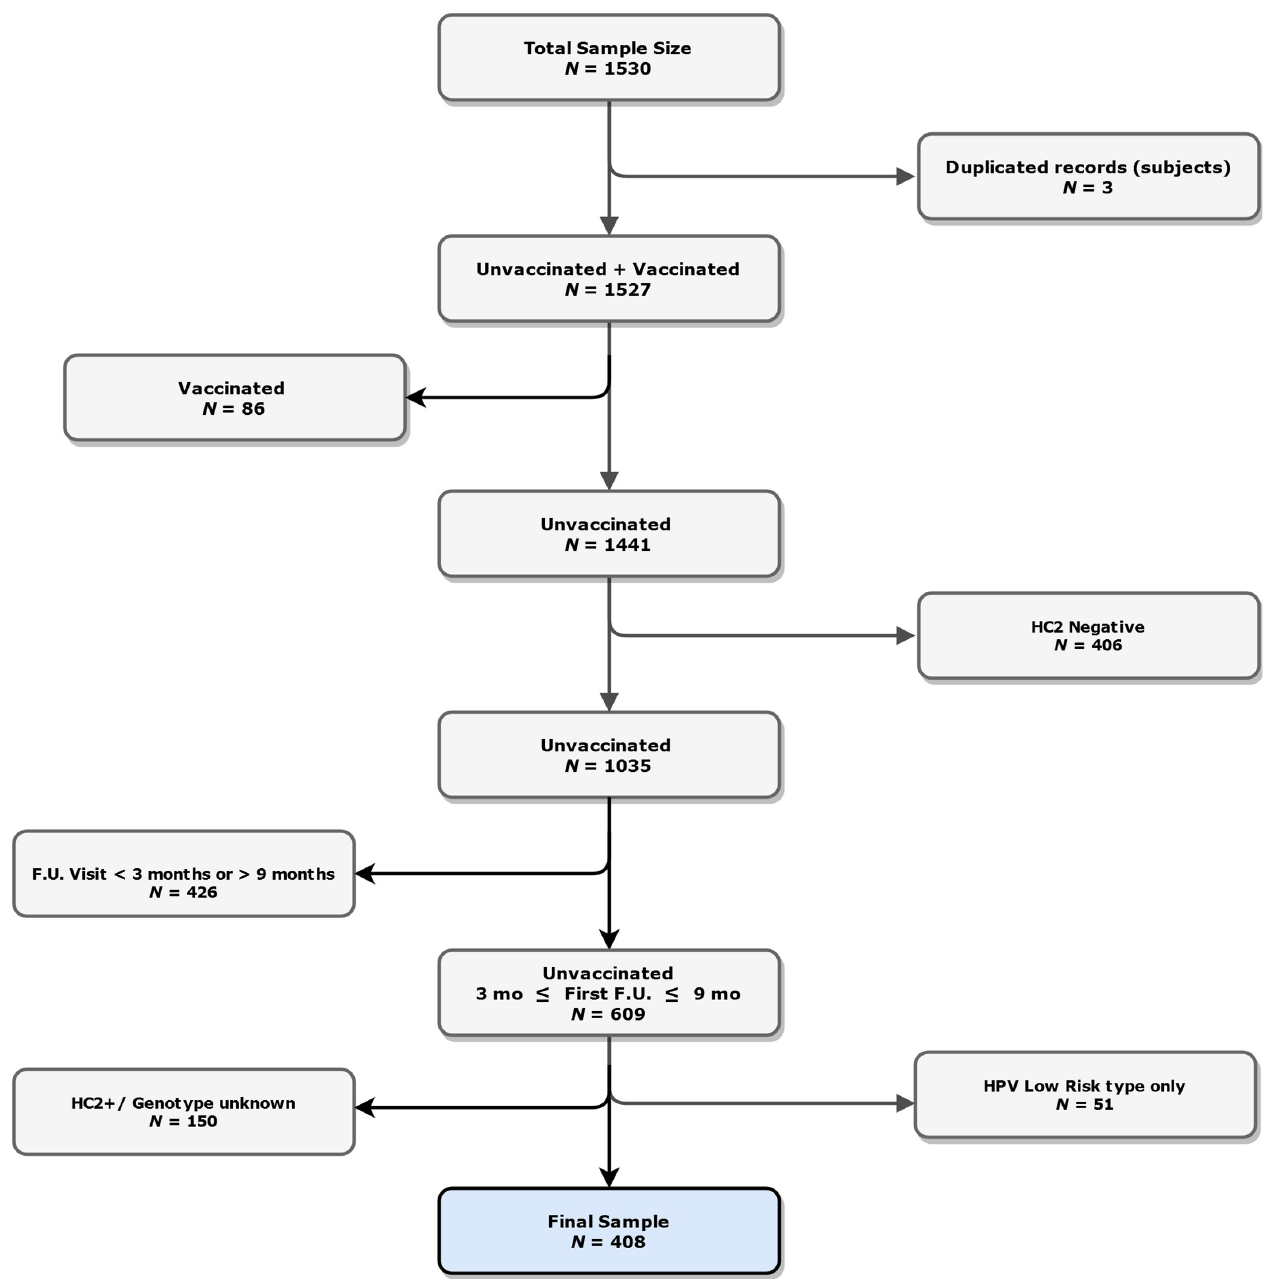
Figure 1. Patients’ inclusion and exclusion criteria flow-chart. HC2 = Hybrid Capture 2, F.U. = follow-up, HPV = Human Papillomavirus, mo =